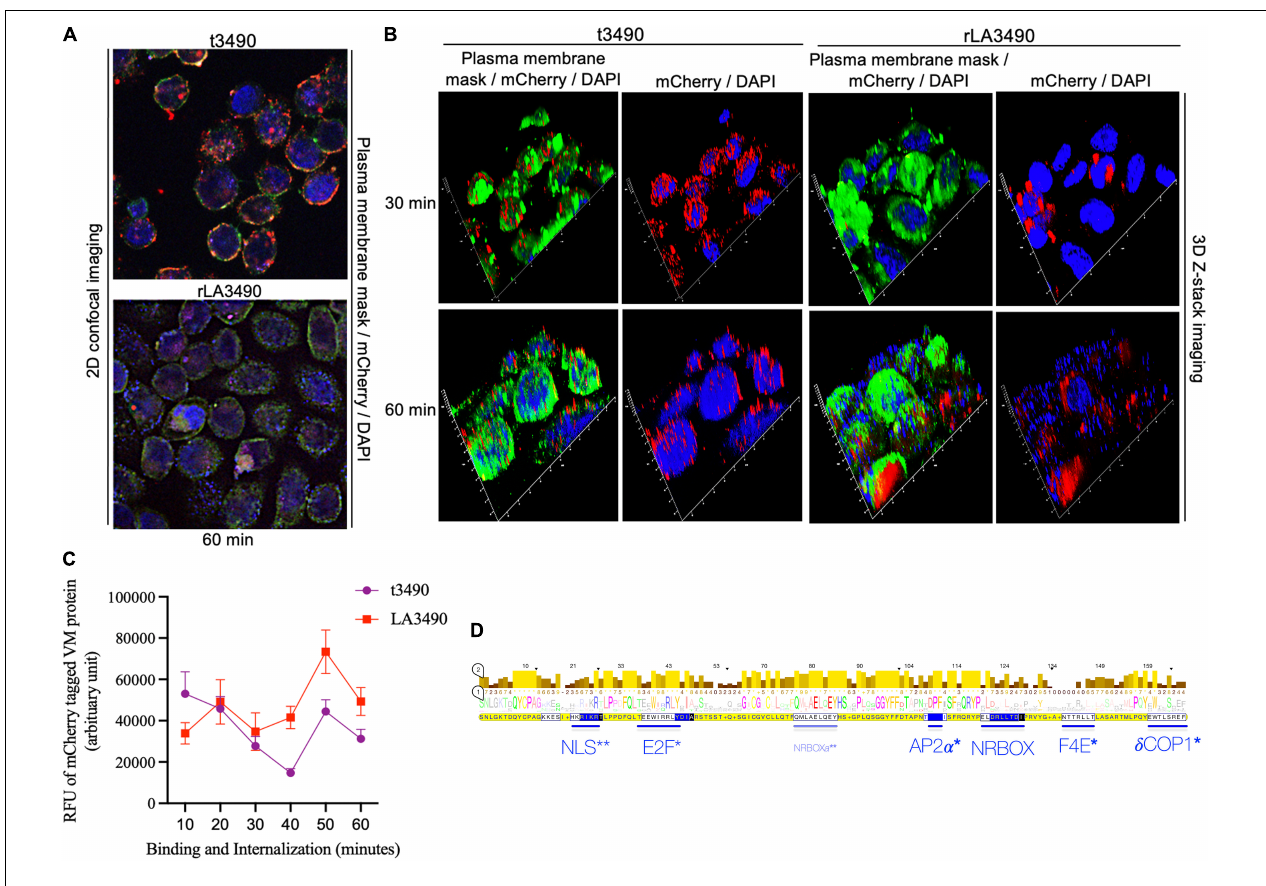
FIGURE 5 | Surface binding and nuclear localization of rLA3490 in HeLa cells. Fluorescent confocal microscopy demonstrating kinetics of binding of mCherry–rLA3490 and mCherry–t3490 fusion proteins binding to HeLa cells. (A) Two-dimensional view, at 60 min, t3490 is visible only on the cell surface (red); rLA3490 is internalized by 60 min (red/pink). (B) Three-dimensional Z-stack and orthogonal images obtained by high-resolution fluorescent confocal microscopy showing internalization of mCherry–rLA3490 fusion from 30 min onward, with nuclear translocation and chromosomal degradation (shown by patchy DAPI staining, lower right) evident within 60 min. t3490 remained on the cell surface at 30 and 60 min. Visualization of treated cells was done after staining with CellMask TM green plasma membrane stain mounting with ProLong TM Gold Antifade Mountant + DAPI nuclear stain. Images were captured using an oil immersion × 100 objective using appropriate filters (blue, DAPI; green, plasma membrane; red, mCherry fusions). (C) Time-dependent interactions of mCherry-tagged rLA3490 and t3490 proteins with HeLa cells (surface binding plus internalization). Fluorescent confocal microscopy (using ImageJ version 1.53 software) was used to quantify recombinant fusion proteins with HeLa cell monolayers. Monolayers were exposed to 45 nM recombinant fusion proteins or controls up to 60 min. Fluorescence intensities of mCherry–t3490 and –LA3490 fusion proteins were measured in 10-min intervals from 0 to 60 min. Data were visualized in GraphPrism 8. (D) Eukaryotic trafficking and protein–protein interaction motifs found in Leptospira VM proteins. Consensus amino acids in larger letters indicate fully conserved residues. Statistically well-supported motif mimics ( p < 10 − 3 ) were identified via the Eukaryotic Linear Motif resource (http://elm.eu.org). Those predicted to be involved in intracellular trafficking (*) and nuclear translocation (**) are shown in blue. Bars indicate location and length, and consensus sequences are boxed. NLS, nuclear localization signal. NRBOX, nuclear receptor box (or LxxLL) motif confers binding to nuclear receptors and is present in the C-terminal domain of all VM protein paralogs [including the natural L. interrogans deletion variant, Q72N53 (LA0591 cluster ID)]. Q72UG2 (LA3490) contains an additional LxxLL motif depicted as NRBOXa. E2F, LxxLFD motif characteristic of E2F family transcription factor. AP2 a, DPF/W motif binds alpha and beta subunits of AP2 adaptor complex. F4E, variant YxxxxL motif mediates binding to the dorsal surface of eukaryotic translation initiation factor, eIF4E. d COP, di-tryptophan motif predicted to mediate retrograde trafficking from Golgi to the endoplasmic